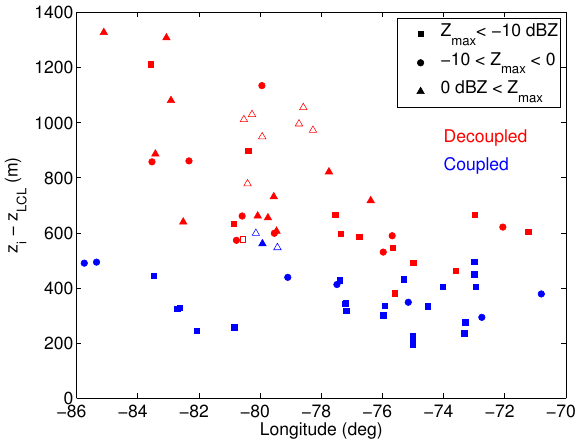
Fig. 9. Decoupling and mixed layer cloud thickness 1z M by longi- tude for each profile. Blue (red) markers indicate well-mixed (de- coupled) profiles. POC profiles are indicated by the hollow